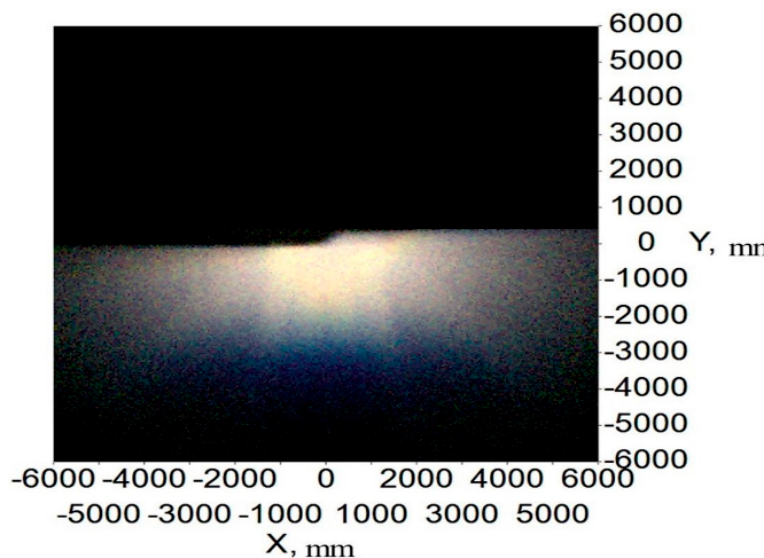
Figure 15. The color distribution of low beam.